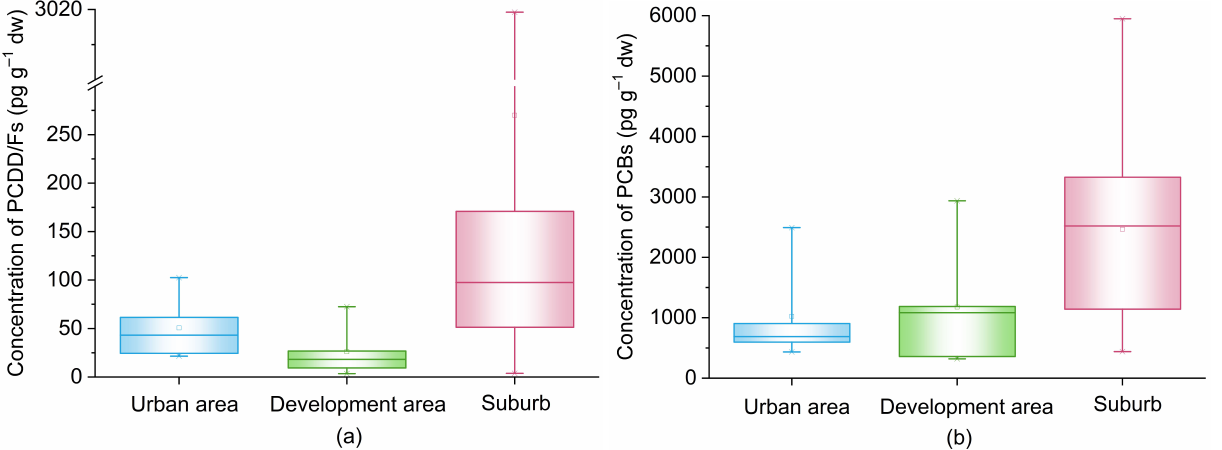
Figure 2. Spatial distribution of polychlorinated dibenzo-p-dioxins and dibenzofurans (PCDD/Fs) ( a ) and polychlorinated biphenyls (PCBs) ( b ) in the three functional urban areas in Beijing. Urban area included 5 sites, L01–L05; development area included 5 sites, L06 and L22–L25; suburb included 17 sites, L07–L21 and